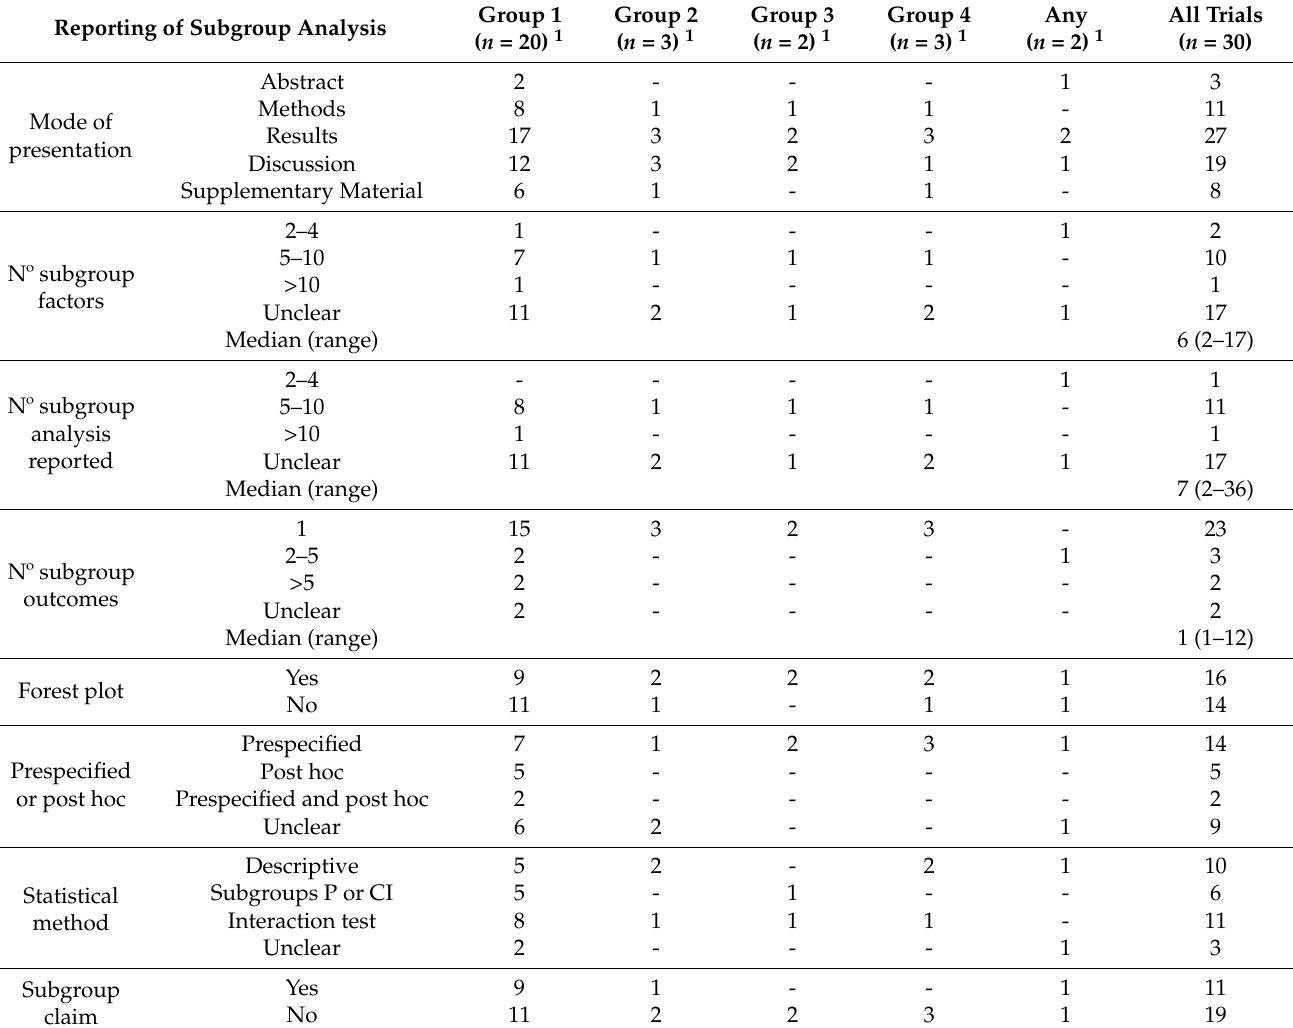
Table 2. Characteristics of subgroup analysis